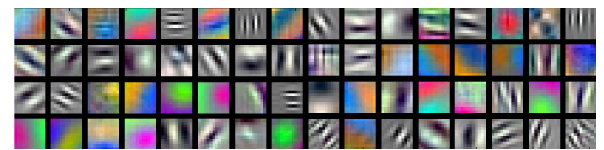
Figure 6. Features of the pretrained VGGNet in the first convolutional layer computed in MATLAB . The appearance of the filter masks is similar to gabor and blob filters.